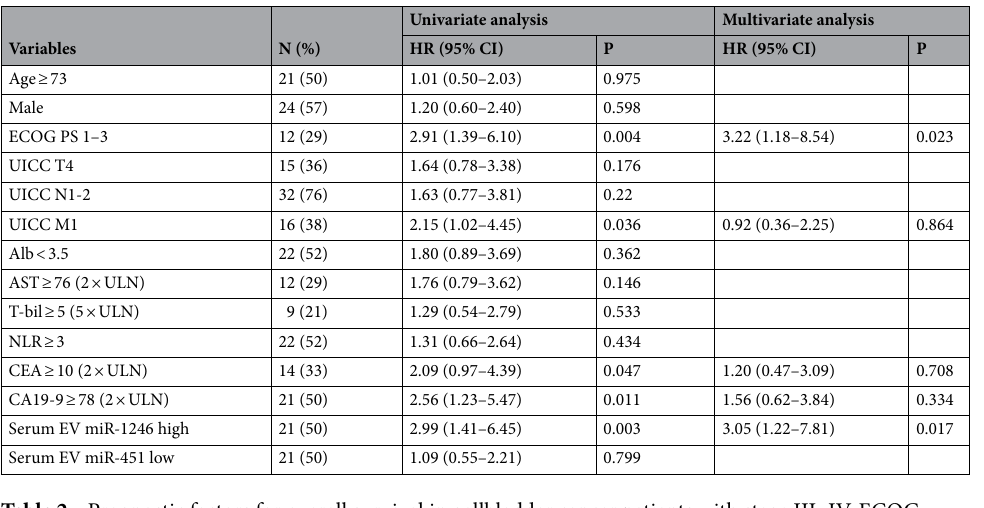
Table 2. Prognostic factors for overall survival in gallbladder cancer patients with stage III–IV. ECOG, Eastern Cooperative Oncology Group; PS, Performance status; UICC, Union for International Cancer Control; Alb, albumin; AST, aspartate transaminase. T-bil, total bilirubin; NLR, neutrophil-to-lymphocyte ratio; CEA, carcinoembryonic antigen; CA19-9, carbohydrate antigen 19-9; EV, extracellular vesicles. ULN, upper limit of normal; HR, hazard ratio; CI, confidence